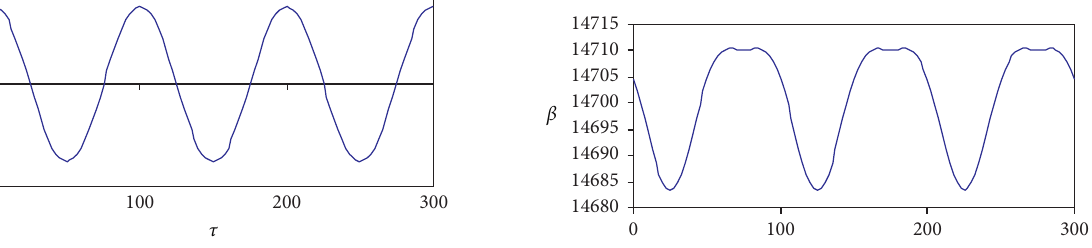
Figure 22: The analytical solution Φ for case (ii) in Section 4.2.